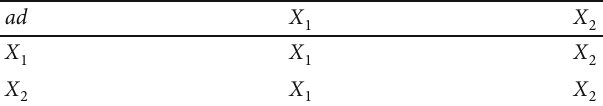
Table 4: Adjoint